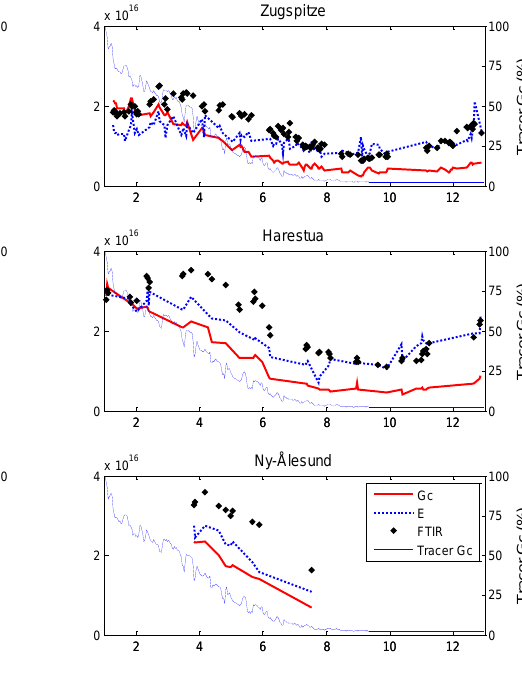
H 2 6 Fig. 4. As in Fig. 3 but for C 2 H 6 .